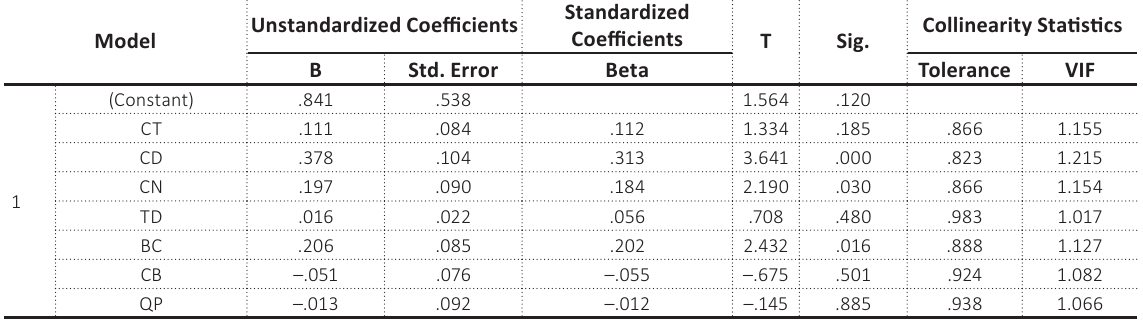
Source: Authors’ elaboration.